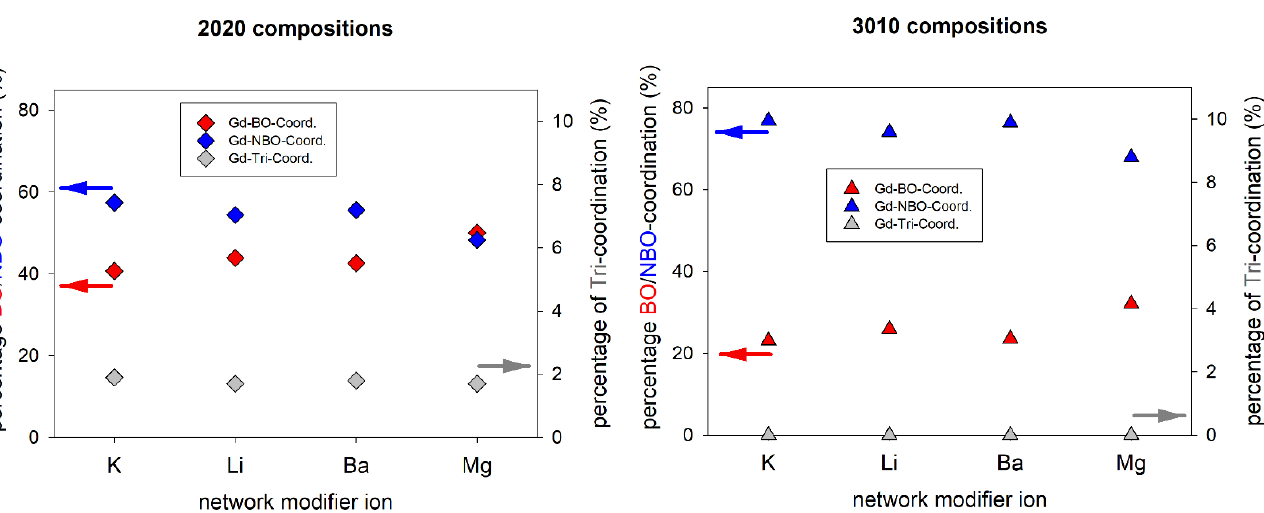
15 of 19 Table 8. Separation of Gd-O coordination numbers (CN) into non-bridging oxygen (NBO), bridging oxygen (BO), and tri- cluster oxygen ions (Tri) and their fractions. CN Fraction